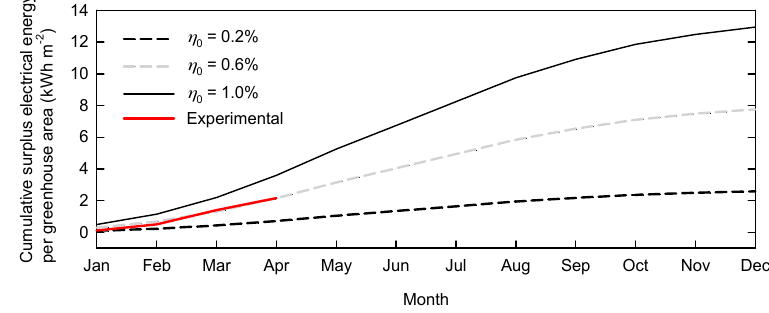
Figure 14. Calculated surplus electrical energy of the PV blind per unit greenhouse area estimated based on local insolation statistics, assuming η 0 of 0.2, 0.6, and 1.0%. The experimentally obtained surplus energy is also depicted. Table 4. Annual electrical energy demand per unit greenhouse area at different locations with various electrical loads.